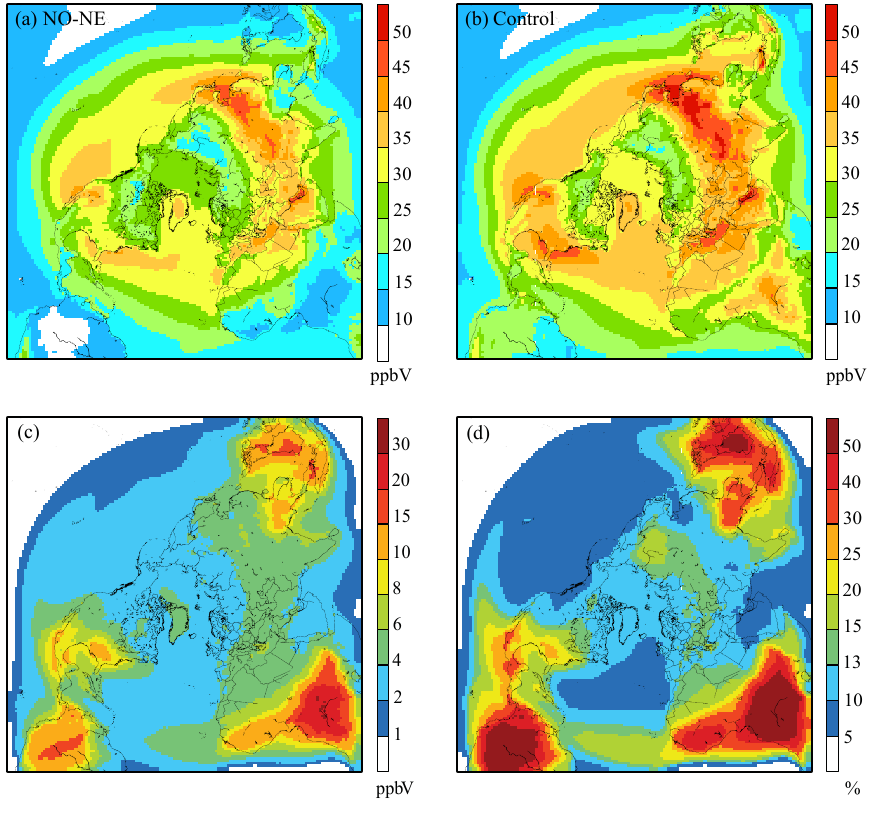
Fig. 11. The annual average ozone mixing ratios (ppbV) simulated by DEHM for (a) a sensitivity simulation by turning off all natural emissions (NO-NE), and (b) a control simulation including all emission sources, for 2006, together with (c) their absolute, (d) and relative percentage